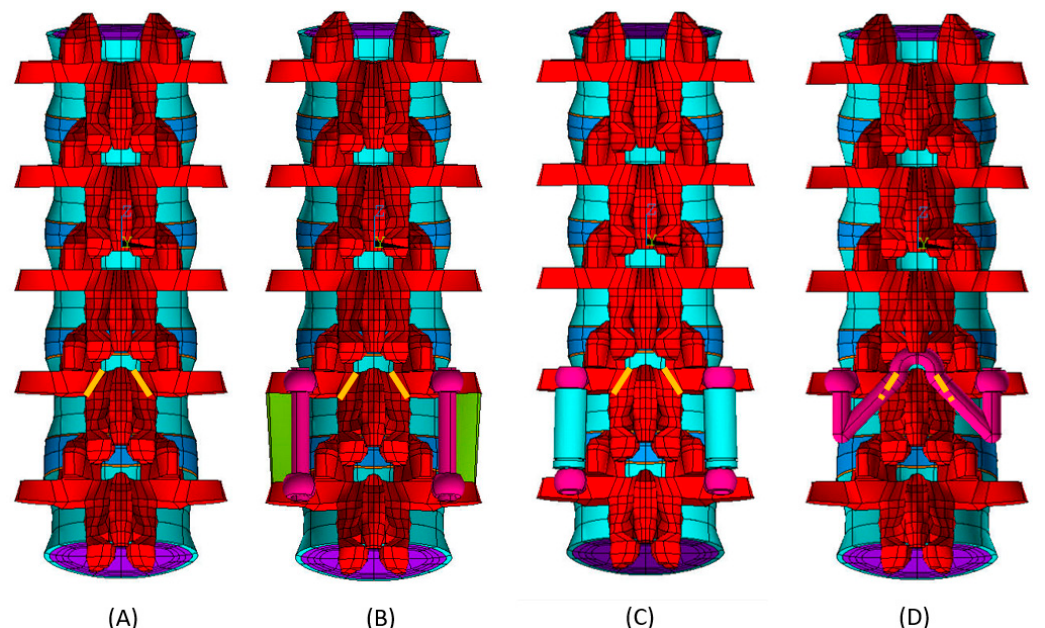
Figure 3. ( A ) Bipars. ( B ) Bipars_PLF. ( C ) Bipars_Dyn. ( D ) Bipars_Wtyp. Note: yellow line indicates the fracture